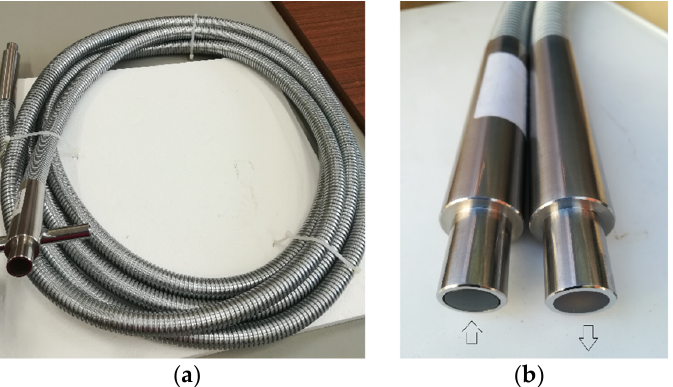
Figure 1. ( a ) Photo of a 7 m optical fiber bundle/cable specially designed to transmit concentrated sunlight (up to 1000 W); ( b ) detail of the terminals (inlet and outlet) of the optical fiber bundle/cable.